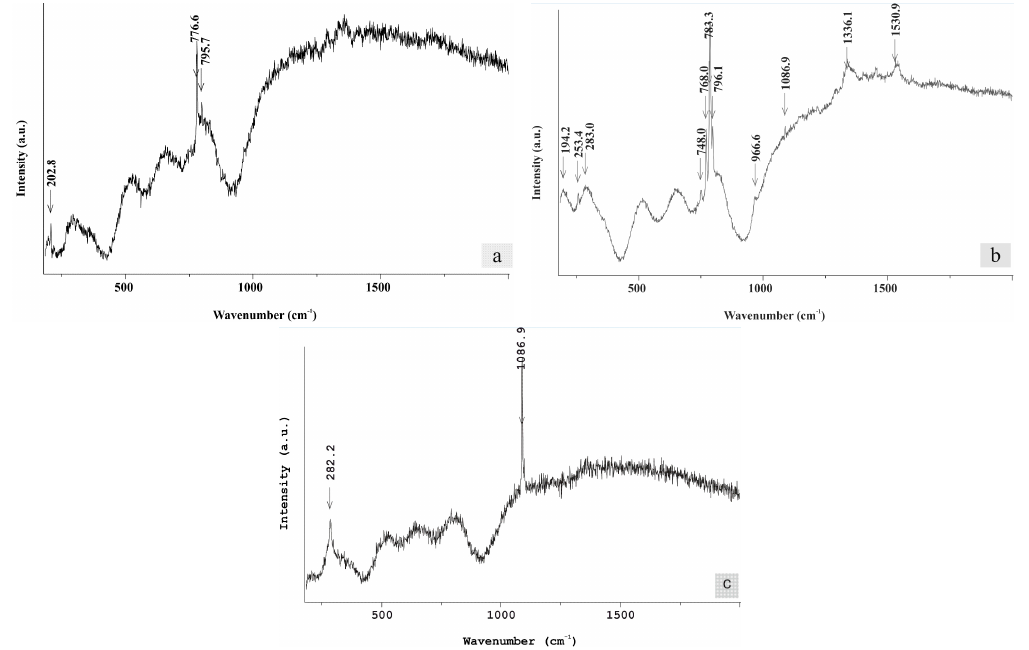
Figure 8. Representative Raman spectra of REE-bearing carbonates with dominant bands at around: ( a ) 795, 776 and 202 cm − 1 ; ( b ) 1086, 796, 783 and 768 cm − 1 ; and ( c ) 1086 and 282 cm − 1 .